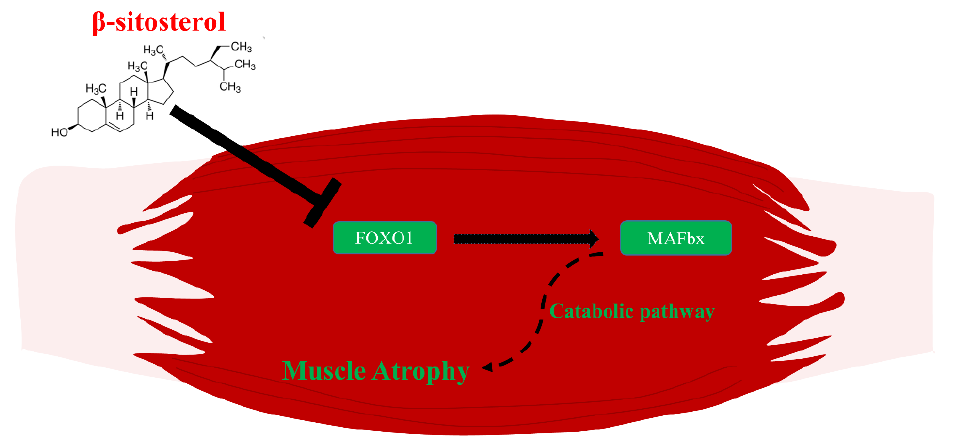
Figure 6. The overall β -sitosterol mechanisms related to muscle atrophy. β -sitosterol down-regulates the transcriptional factor, FoxO1. Down-regulated FoxO1 becomes unable to affect the expression of MAFbx. Consequently, inhibited MAFbx cannot induce muscle atrophy via the catabolic pathway. In aging sarcopenia, it may be difficult to achieve desired muscle strength improve- ment and muscle mass increase even with appropriate exercise due to inflammation and degeneration of neuromuscular junctions. Nevertheless, the mechanism of the study of the mitochondrial electron transport system conducted by Wong et al. and the mechanism of inhibition of muscle degradation by blocking the ubiquitin-proteasome pathway demon- strated in our study proves the important possibility of using β -sitosterol for the inhibition of aging sarcopenia